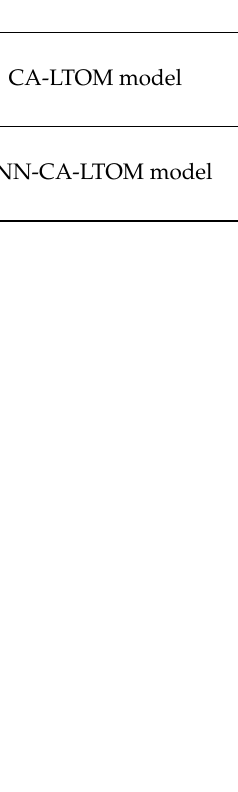
Table 9. Changes in area of the three major land use types in the Nansha District from 2020 to